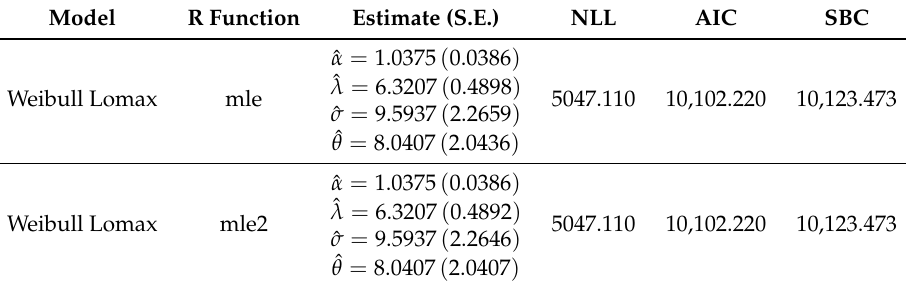
Table 1. R optimization function, parameter estimates, standard errors (S.E.), Akaike’s information criterion (AIC) and Schwarz’s Bayesian criterion (SBC) under composite Weibull–Pareto (CWL) distribution model for allocated loss adjustment expenses (ALAE)